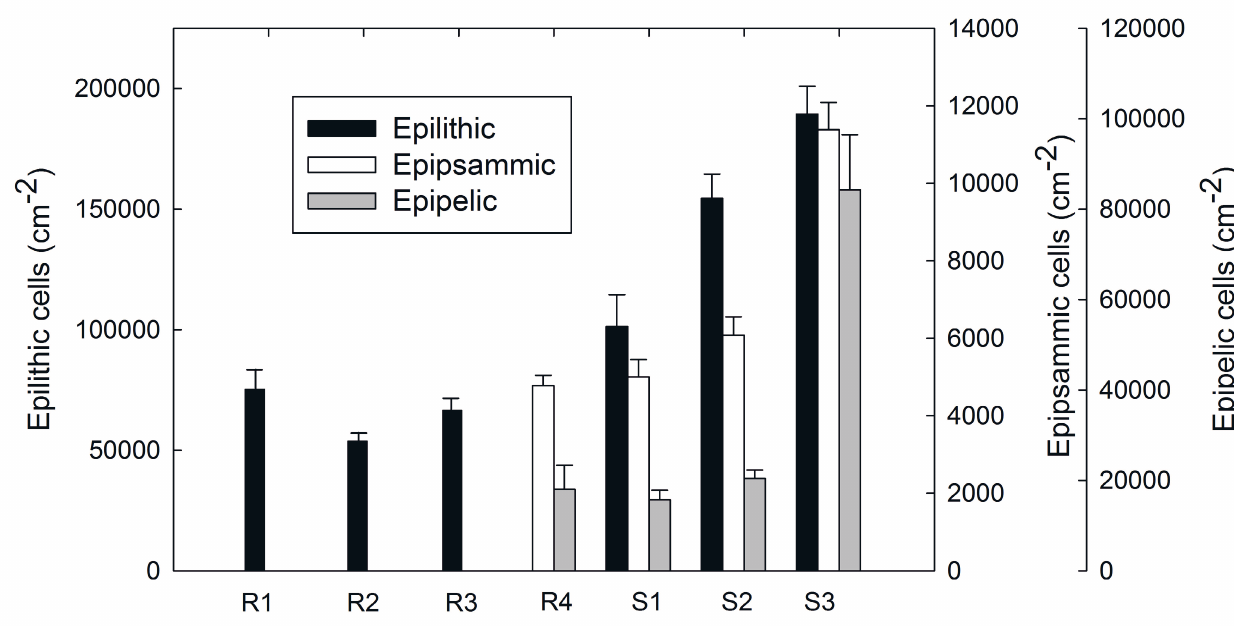
Figure 3. Mean diatom abundance (+SE) of epilithic, epipsammic and epipelic assemblages along a natural CO 2 gradient ( n = 10 per